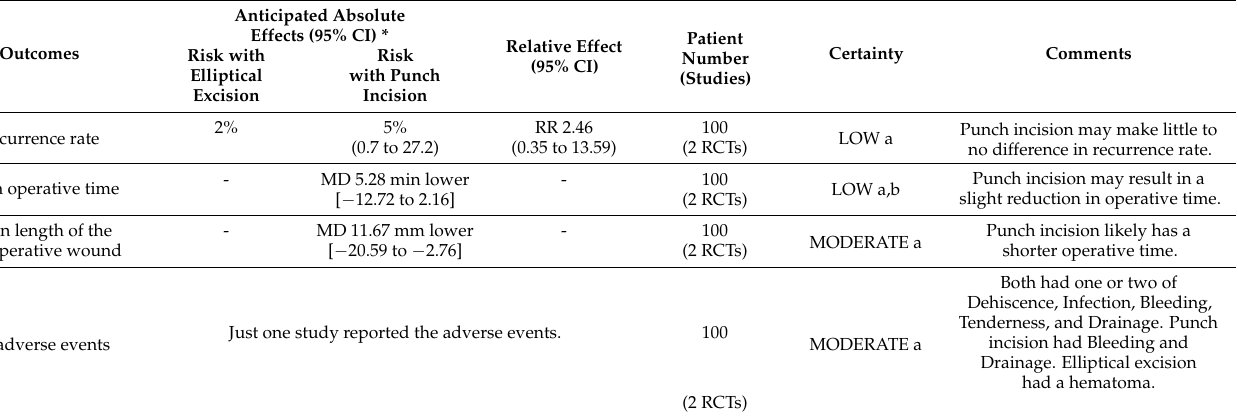
Table 3. Summary of Findings